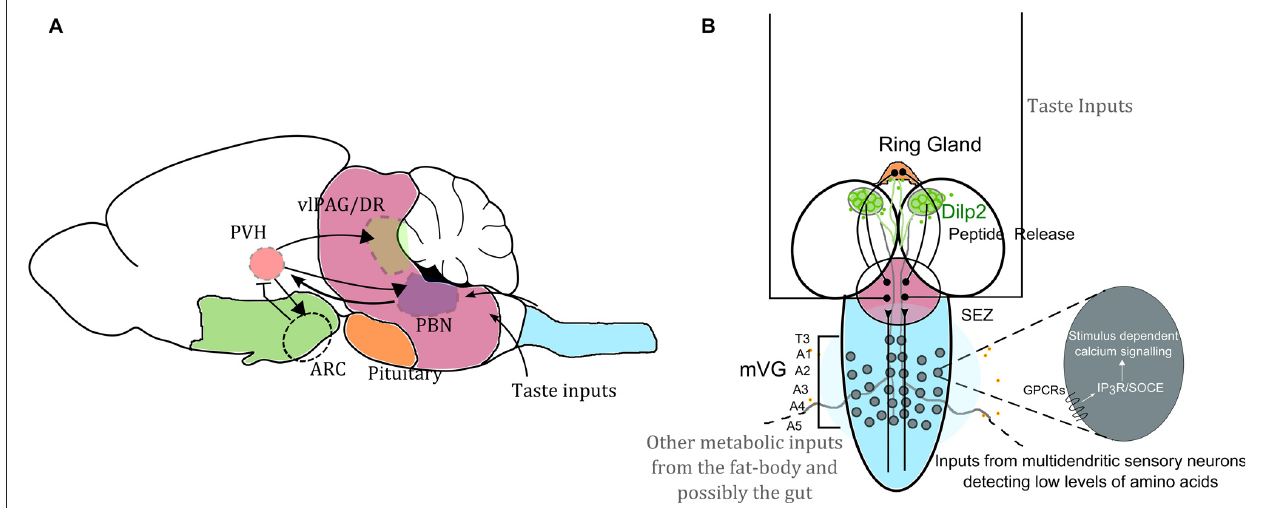
FIGURE 1 | Neuronal circuit motifs regulating feeding and satiety are conserved between mammals and Drosophila . Comparison of circuits regulating feeding and satiety in mammals (A) and Drosophila larvae (B) equates the hypothalamus with the medial neurosecretory cells (mNSC; green), the pituitary region to the ring gland (orange), the brain stem to the sub-oesophageal ganglion (SOG or the sub-oesophageal zone, SEZ; pink) and the spinal cord to the ventral ganglion (blue). Studies have shown that the agouti-related peptide (AgRP) neurons and pro-opiomelanocortin (POMC) neurons housed in the arcuate nucleus (ARC) are critical for driving feeding behavior. However, in the absence of these two key cell types, feeding and satiety are also influenced by the paraventricular nucleus (PVH of the hypothalamus), which activates the cells in the ARC as well as drives activity in the para-brachial nucleus (PBN) for attaining satiety (Wu et al., 2009, 2012; Sternson and Eiselt, 2017). Glutamatergic interneurons in the mid-ventral ganglion (mVG) similarly activate the mNSC to regulate response to starvation (Jayakumar et al., 2016). In (A) the arrowheads show activation, and the arrow with the flatline indicates inhibition. The various regions are important for achieving satiety. In (B) we also highlight that intracellular calcium signaling mechanisms through various G-protein coupled receptors (GPCRs) involving both the inositol-1,4,5-trisphosphate receptor (IP 3 R) mediated calcium release as well as store-operated calcium entry (SOCE) in the mVG neurons possibly allow integration of environmental dietary quality with internal metabolic state. Hence the with internal metabolic state. Hence the mVG-mNSC connection in Drosophila larvae may be a precursor of an evolved and complex